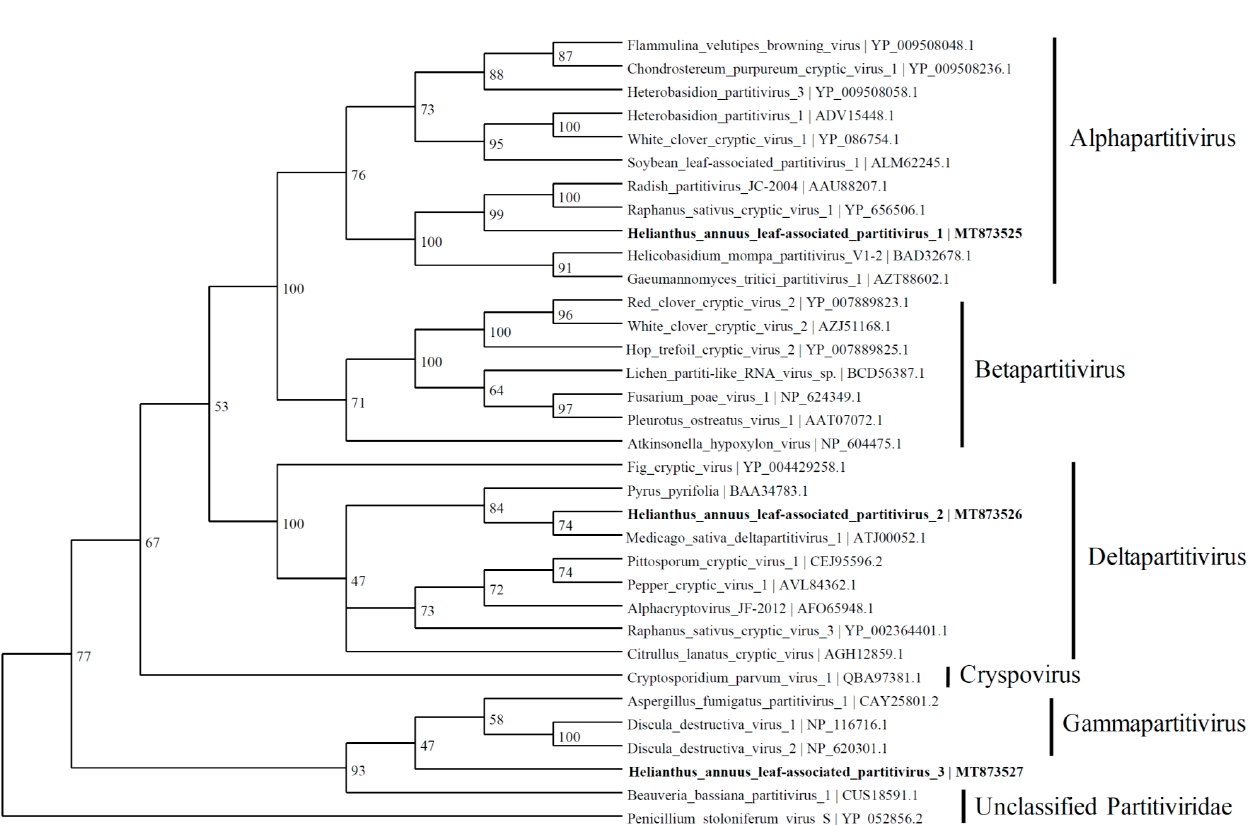
Figure 4. Phylogenetic tree depicting the relationships of the predicted amino acid sequence of RNA-dependent RNA polymerase of the Helianthus annuus leaf-associated partitivirus 1, the Helianthus annuus leaf-associated partitivirus 2, and the Helianthus annuus leaf-associated partitivirus 3 with other confirmed and proposed members of the family Partitiviridae .